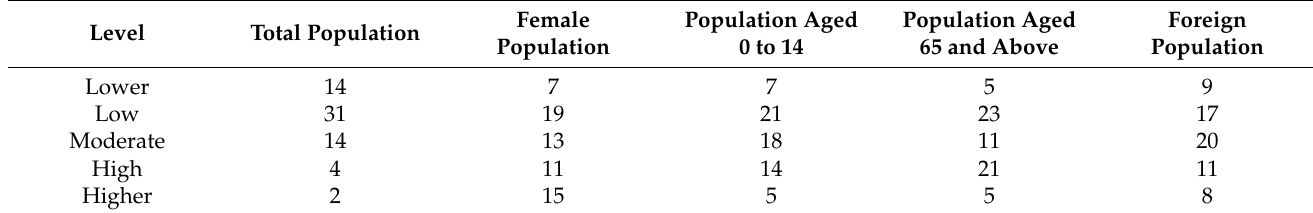
Table 10. Green space demand index in Fuzhou city